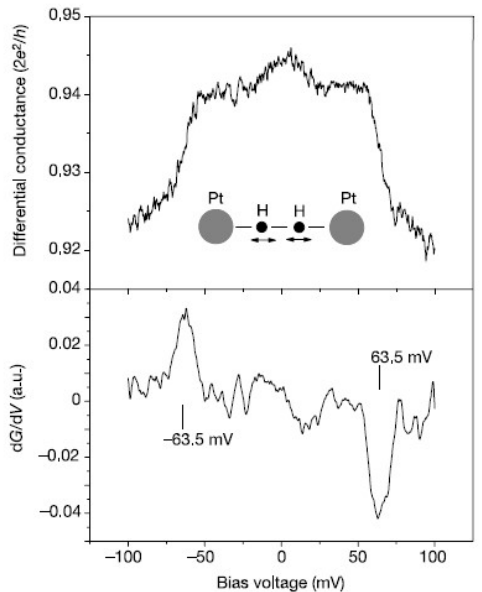
Figure 4. Differential conductance curve (upper panel) and its derivative (lower panel) for the hydrogen single-molecule junction with Pt electrodes measured at a zero bias conductance close to 1 G 0 . Reproduced with permission from [8], copyright Nature Publishing Group 2002.